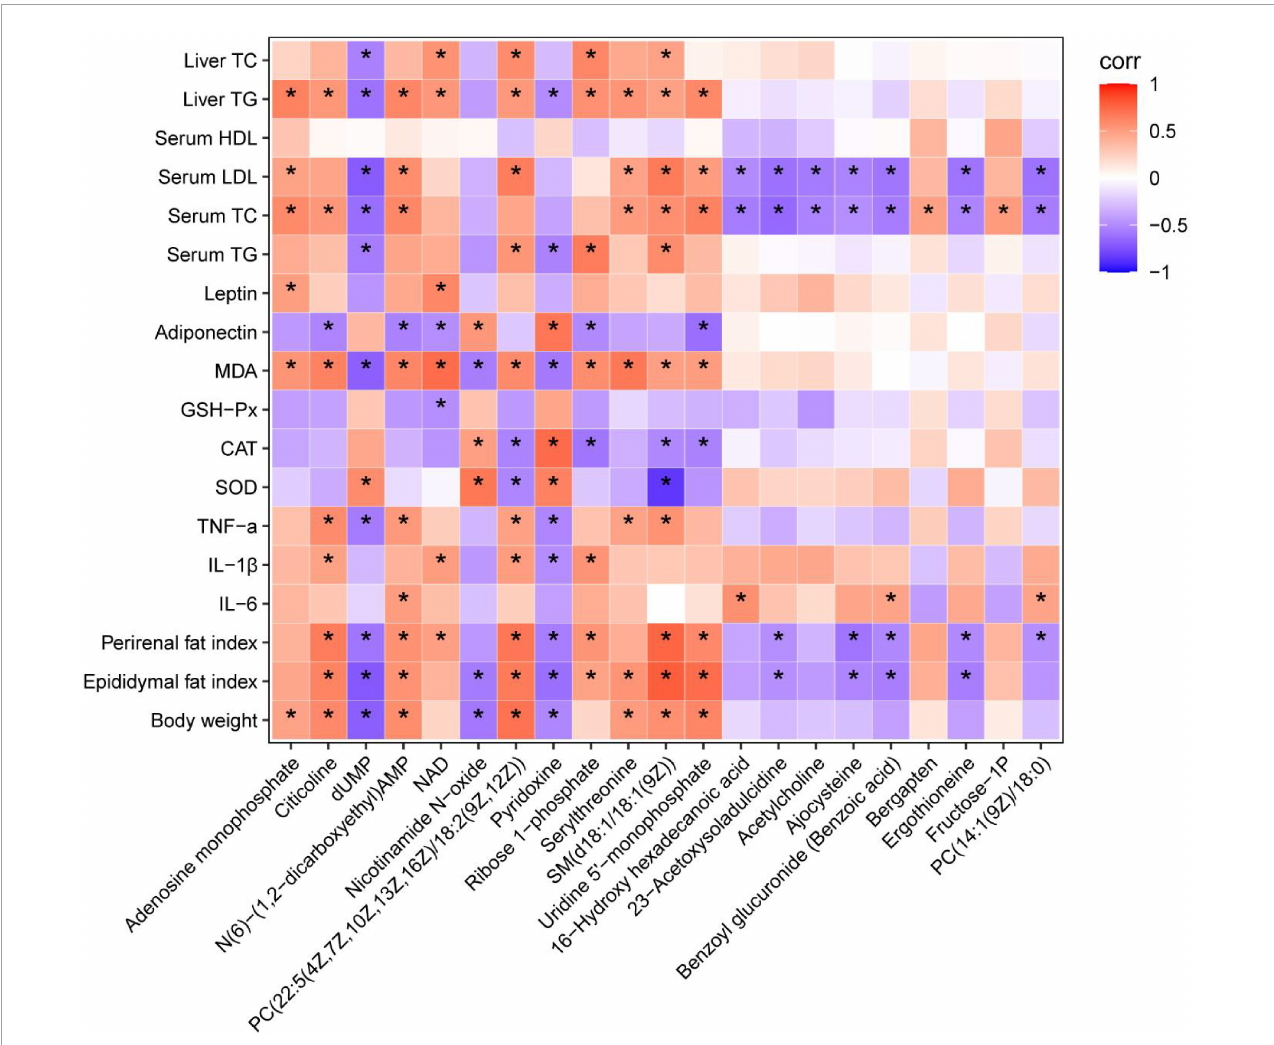
FIGURE7 Heatmap analysis of the Spearman’s correlation of significantly changed metabolites and metabolic syndrome-related indices. Positive correlation is in red and negative correlation is in blue. * p <